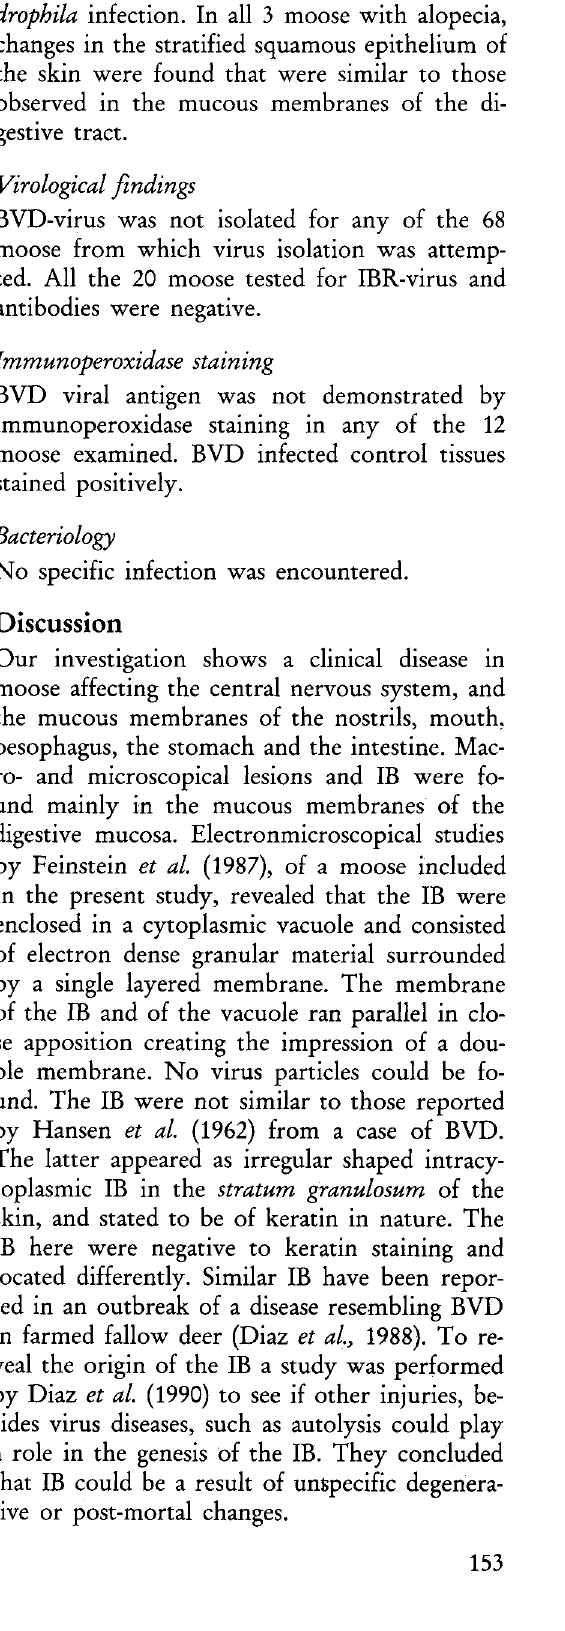
Fig. 5. Papillae bucalis. Note cells in stratum spinosum and granulosum showing clear cytoplasmas, ir regular cell membrane and pyknotic nuclei (arrows).